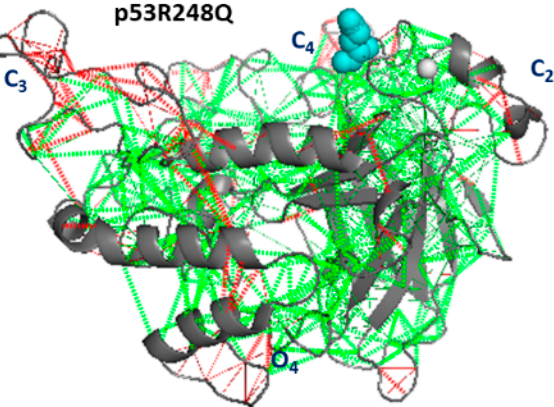
Figure 9. Frustration analysis of p53R248H. The level of frustration is represented by the colored scale: green represents minimal frustration and red high frustration. The mutated residue (248H, cyan) and the Zn ion (grey) are represented as spheres.